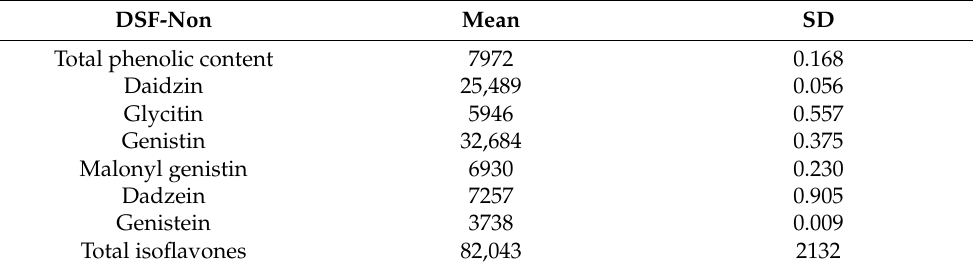
Table 1. DSF-Non total phenolic content.